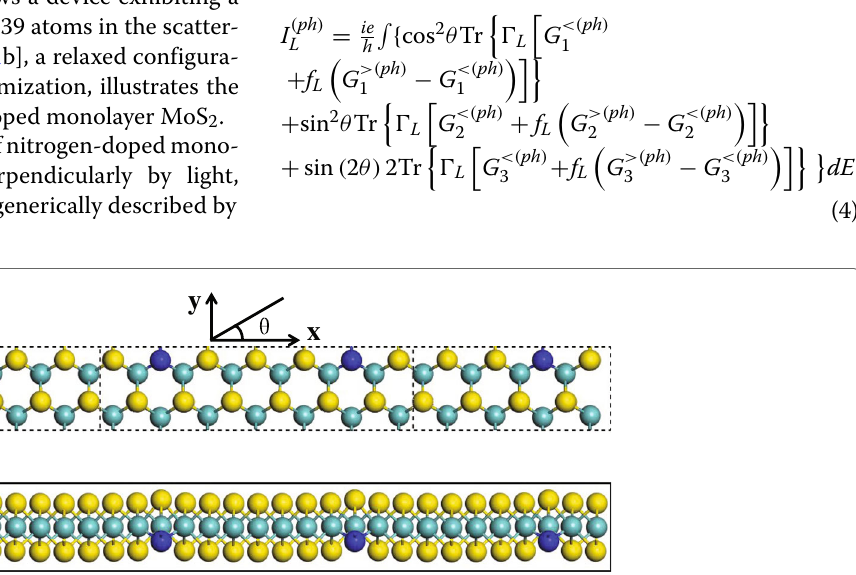
Fig. 1 a Two-probe device structure for calculating the photocurrent of the nitrogen-doped MoS 2 . b The side view of the relaxed configuration of a . The S, Mo, and N atoms are respectively depicted by yellow, light blue, and dark blue. Without bias voltages, the scattering region is irradiated by the polarized light perpendicularly. For the linearly polarized light, the polarization angle θ is measured with respect to the transport